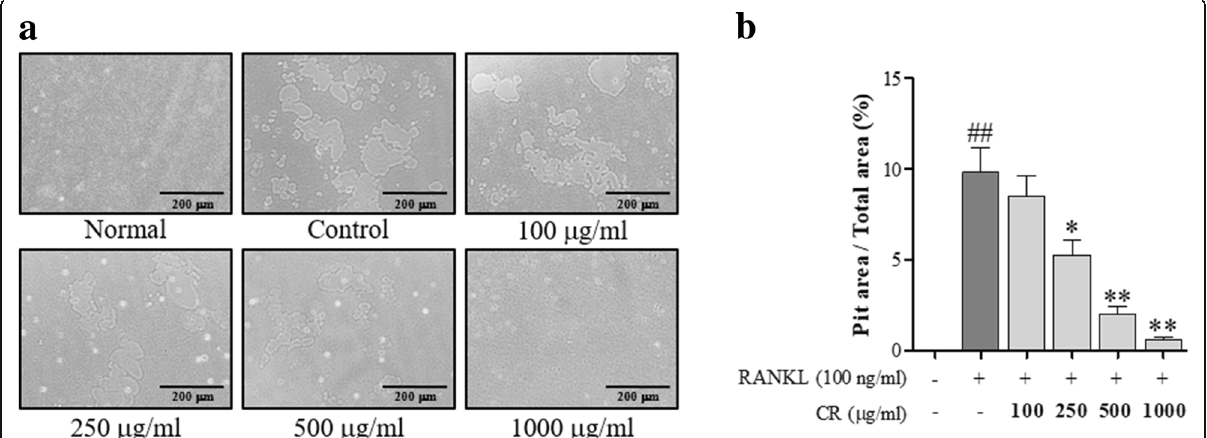
Fig. 4 Effect of CR on pit formation. a Pit area was observed under an inverted microscope (100×, Scale bars: 200 μ m), and b the Pit area was measured using the ImageJ software. Columns and error bars represent the mean ± S. E of three independent experiments. ## p < 0.01 compared with normal and ** p < 0.01, * p < 0.05 compared with the